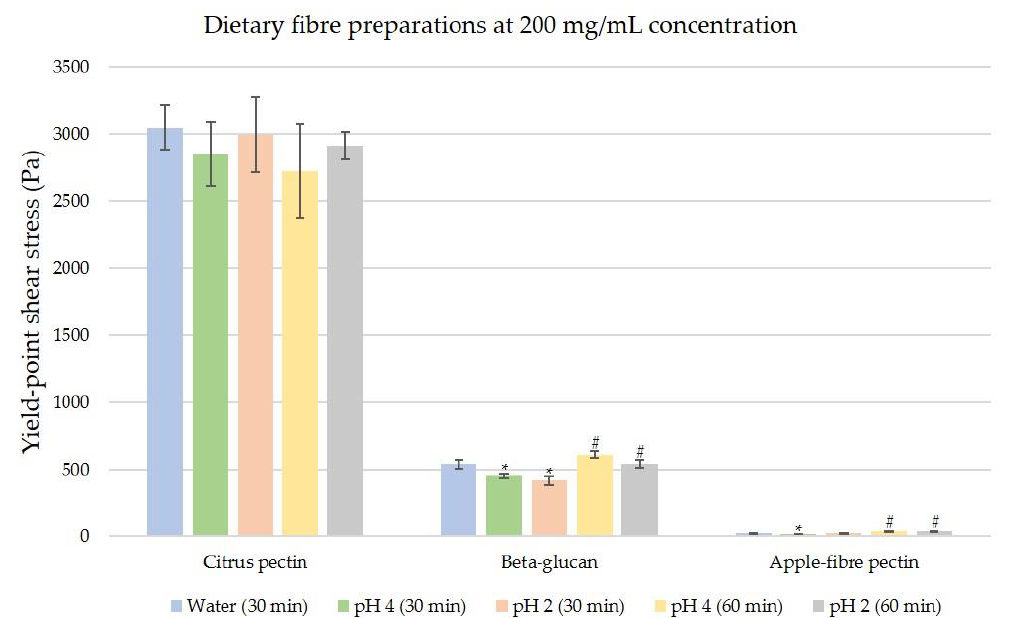
Figure 5. Comparisons of yield-point shear stresses of three ‘medium-viscosity’ fibres; citrus pectin, beta-glucan, and apple-fibre pectin at 200 mg/mL. Test conditions are in distilled water (pH 7), and simulated digestion at pH 4 and pH 2. The data tip (*) indicates significant difference between the distilled water condition and the simulated digestion condition (pH 4 or pH 2) at 30 min. The data tip (#) indicates significant difference between the simulated digestion condition at 30 min (pH 4 or pH 2) and its corresponding simulated digestion condition at 60 min. The significance level is p ≤ 0.05 for both (*) and (#).